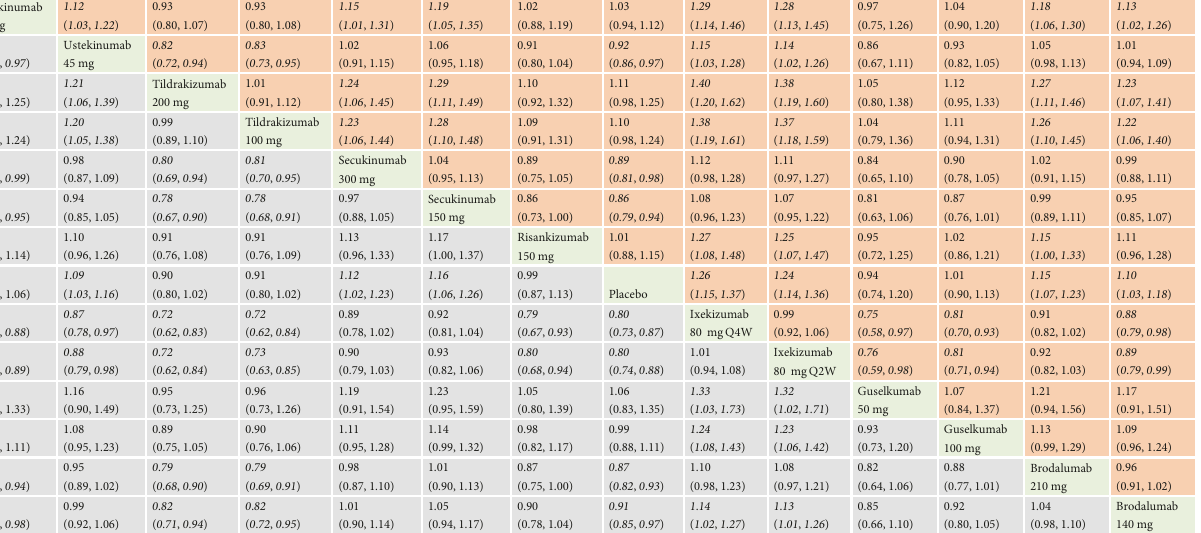
Figure 7: Relative risk with 95% CIs of all interventions from network meta-analysis for adverse events(AEs). Di ff erent interventions in the middle block divide the graph into upper and lower triangles; for the lower triangle, the e ffi cacy estimate is the ratio of the column de fi ning treatment to the row de fi ning treatment. In case that the con fi dence interval does not include 1, if RR > 1 , it favors the row de fi ning treatment. In contrast, if RR < 1 , it favors the column de fi ning treatment. The upper triangle is symmetrical to the lower triangle. The e ffi cacy estimate is the ratio of the row de fi ning treatment to the column de fi ning treatment. The results are mutually reciprocal. Statistically signi fi cant results have been applied with italic